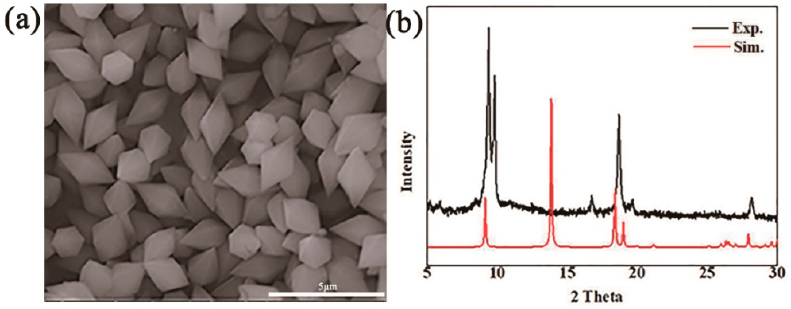
Figure 2. Characteristics of MIL-53(Fe). ( a ) SEM image of MIL-53(Fe), which is octahedral in diamond-shape, owing to corner-sharing chains of iron ion clusters connected through terephthalate linkers, and channels size about 2-3 μ m. ( b ) XPRD spectra of MIL-53(Fe).